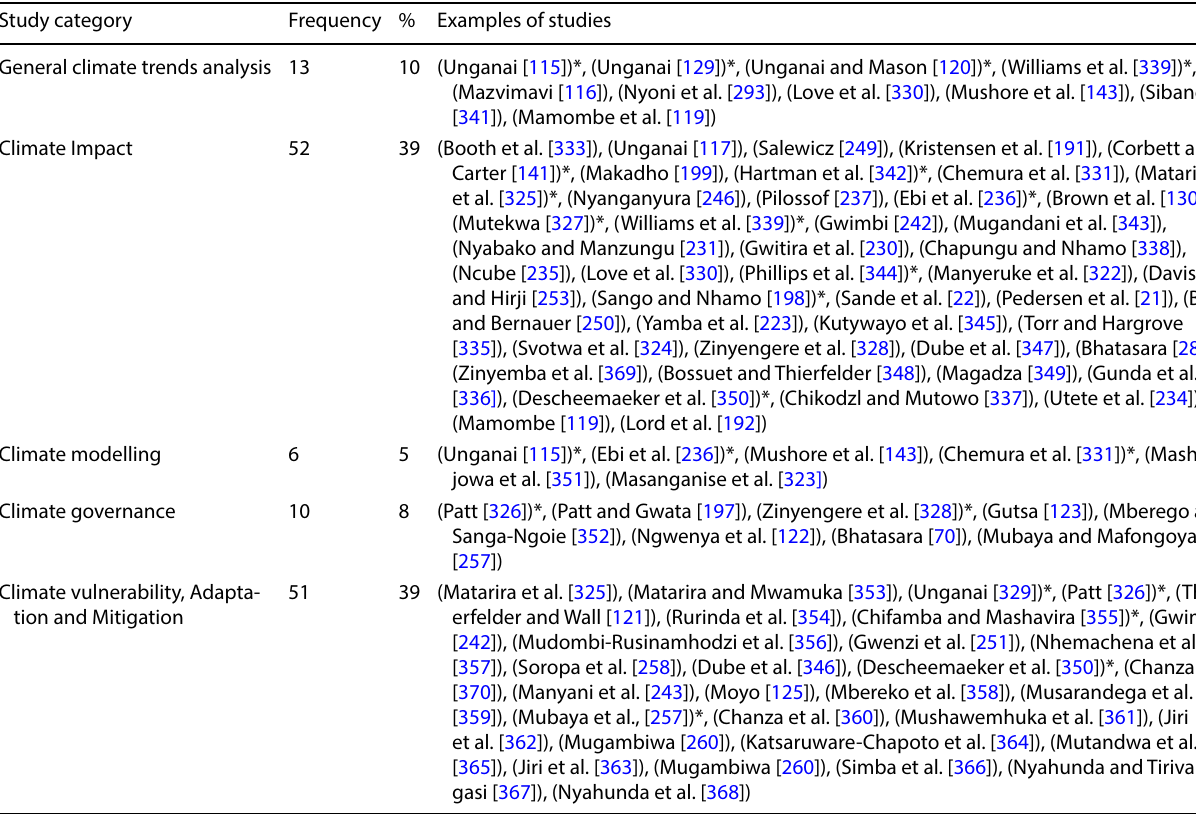
NB, Twenty-five (25) of the studies marked with an asterisk (*) fall within at least two categories considering